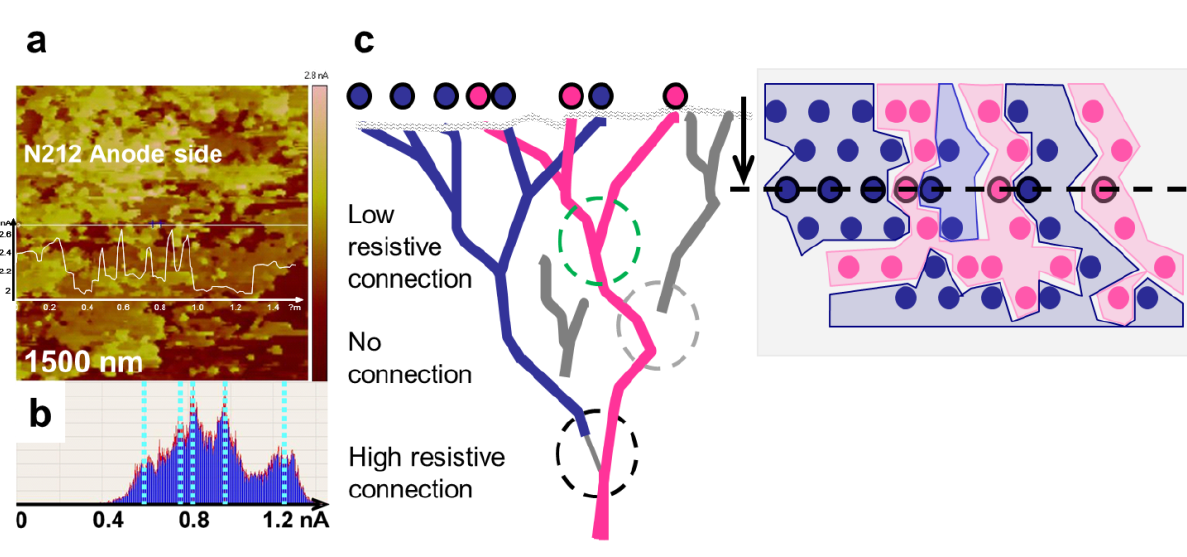
Figure 12. ( a ) PeakForce-QNM ® current of the Nafion ® 212 half-MEA at the anode side after 1600 h of operation at open-circuit voltage; ( b ) Histogram with distinct current level; ( c ) Schematic drawing of interpenetrating ionic subnets with a conductive, a highly resistive, or no subsurface